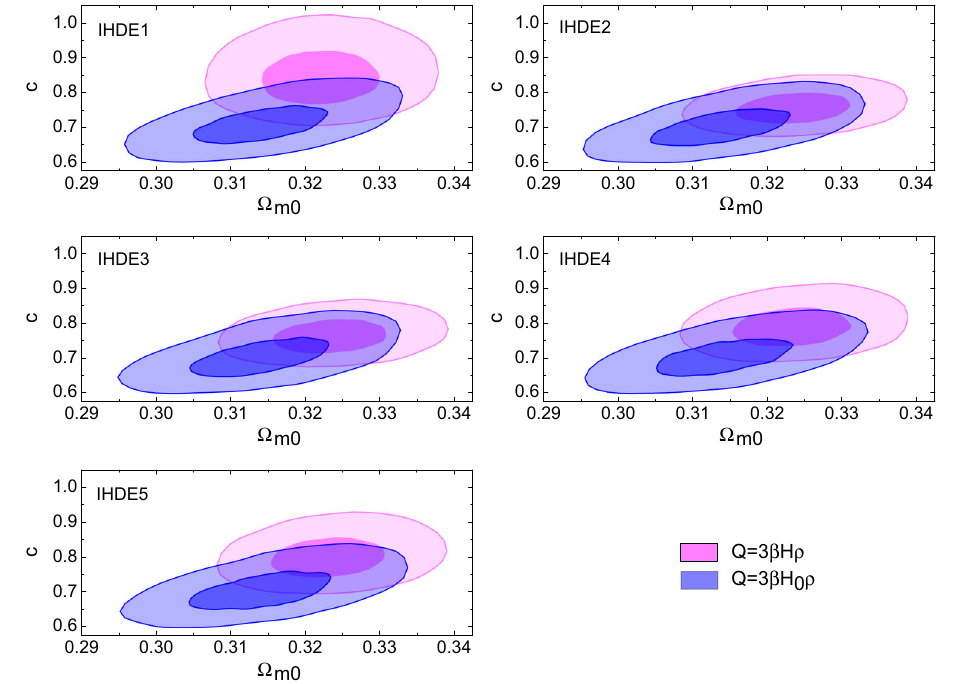
Fig. 2 The SN + CMB + BAO + H 0 constraints on the HDE model and the IHDE models. The 68.3 and 95.4% confidence level contours are shown in the (cid:7) m0 – c plane